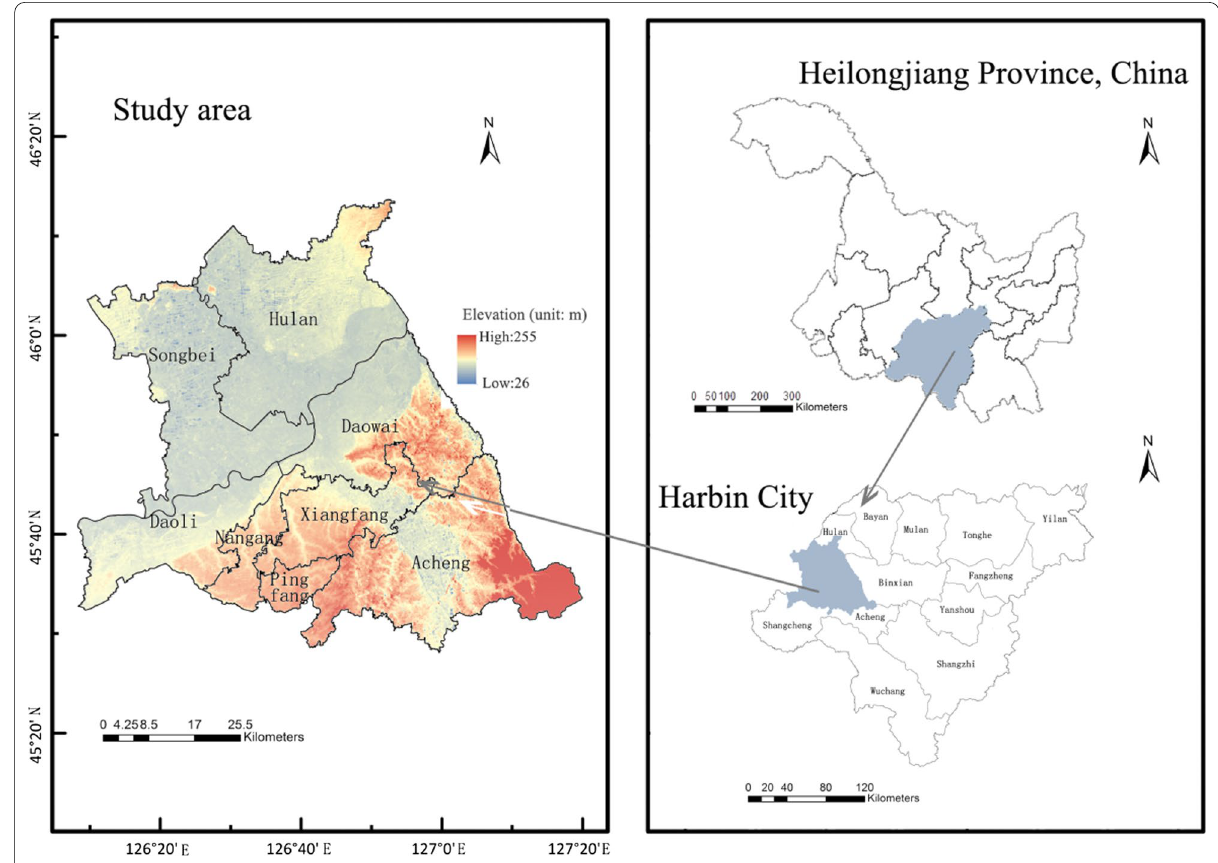
Fig. 2 Location and elevation of the study area. The top‑right subgraph shows an administrative map of Heilongjiang Province, China. The bottom‑right subgraph shows an administrative map of Harbin City. In addition, the left map shows elevation in the study